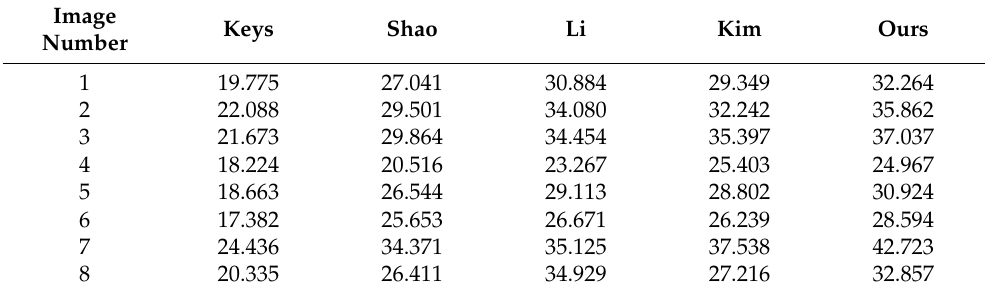
Table 1. Comparison of AG indexes of images reconstructed using different methods.